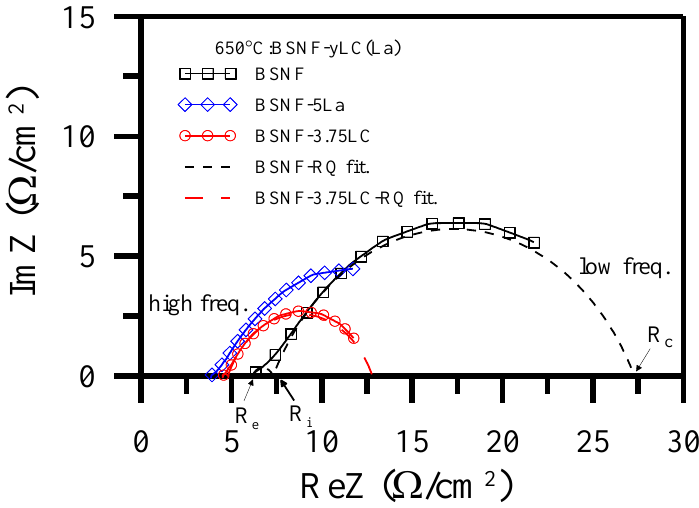
Figure 12. AC impedances of half-cells and RQ fittings for BSNF/LSBC/Pt and (BSNF-3.75 LC)/LSBC/Pt compared with (BSNF-5 La)/LSBC/Pt at 650 °C measurement [72].